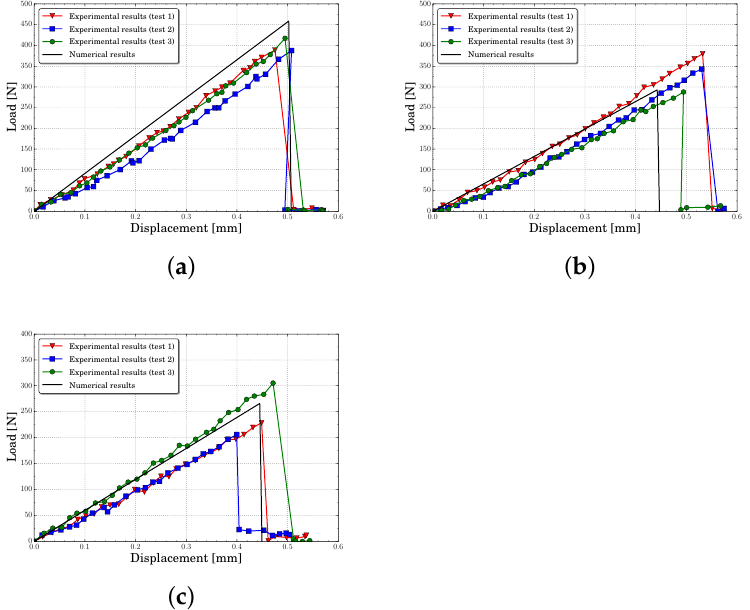
Figure 11. Load-displacement curves for a notch eccentricity of d = 10 mm predicted for different notch lengths a ( a ) a = 6 mm, ( b ) a = 8 mm, ( c ) a = 10 mm.